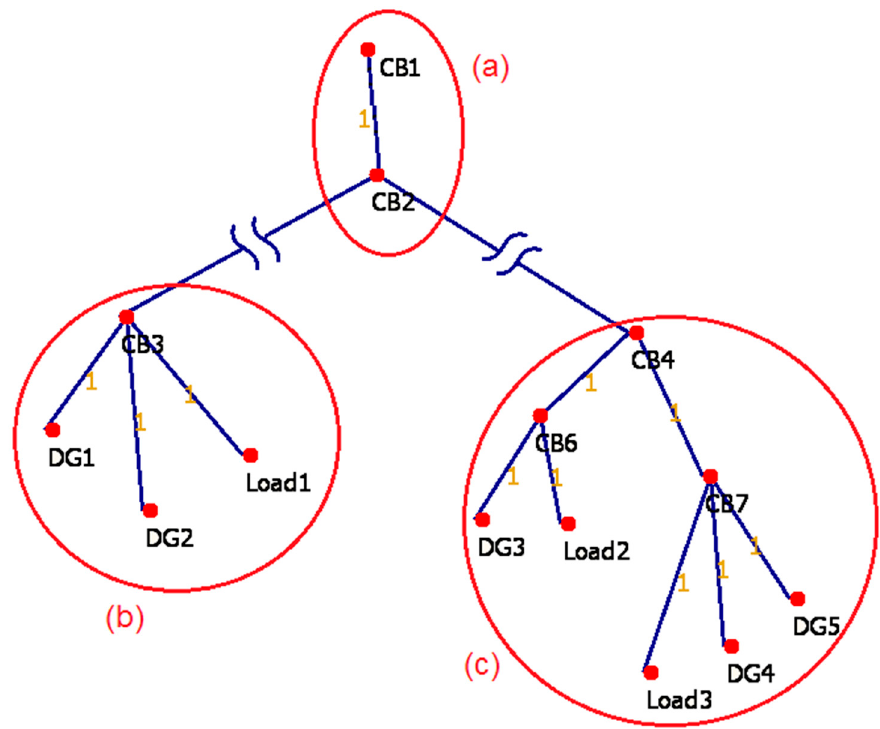
Figure 9. Postdisaster healthy networks modeled with graph theory. Table 2. Application of update algorithm on CB3.